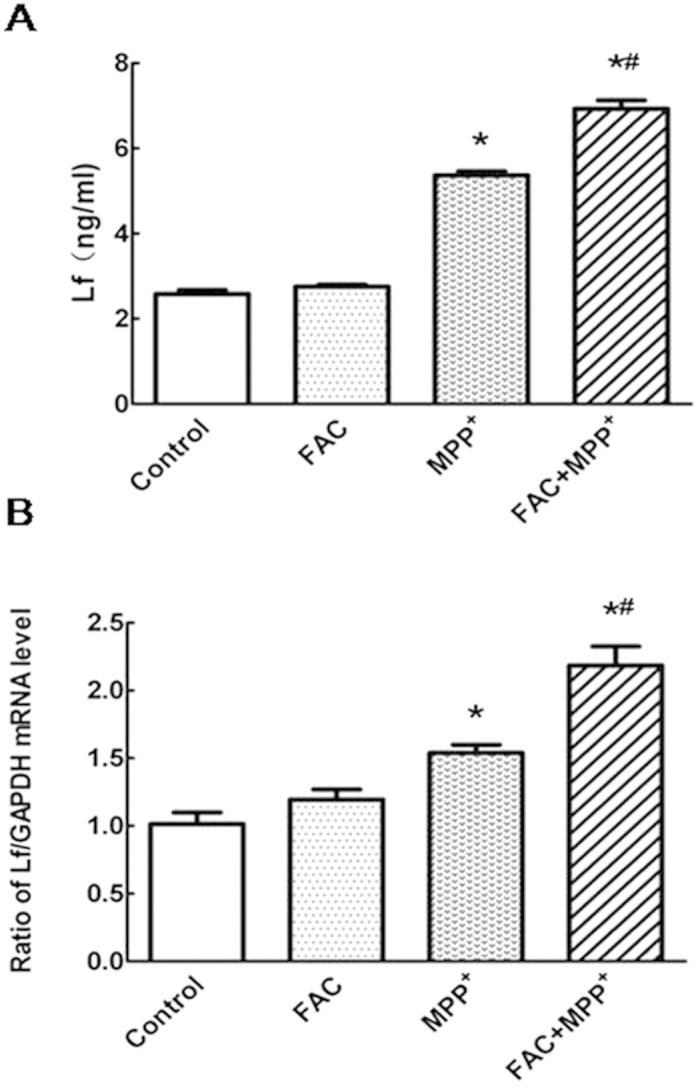
FAC enhanced Lf release and mRNA expression in activated microglia triggered by MPP+.(A) Activation of microglia with MPP+ increased Lf release, which was further enhanced by initial FAC incubation. (B) Lf mRNA levels in MPP+ activated microglia was increased compared with control group. Iron load in microglia elevated the Lf mRNA expression compared with MPP+ group. Data are presented as fold changes in Lf mRNA expression with treatment vs control in microglia. *P < 0.05, compared with the control; #P < 0.05, compared with MPP+ group. n = 6.